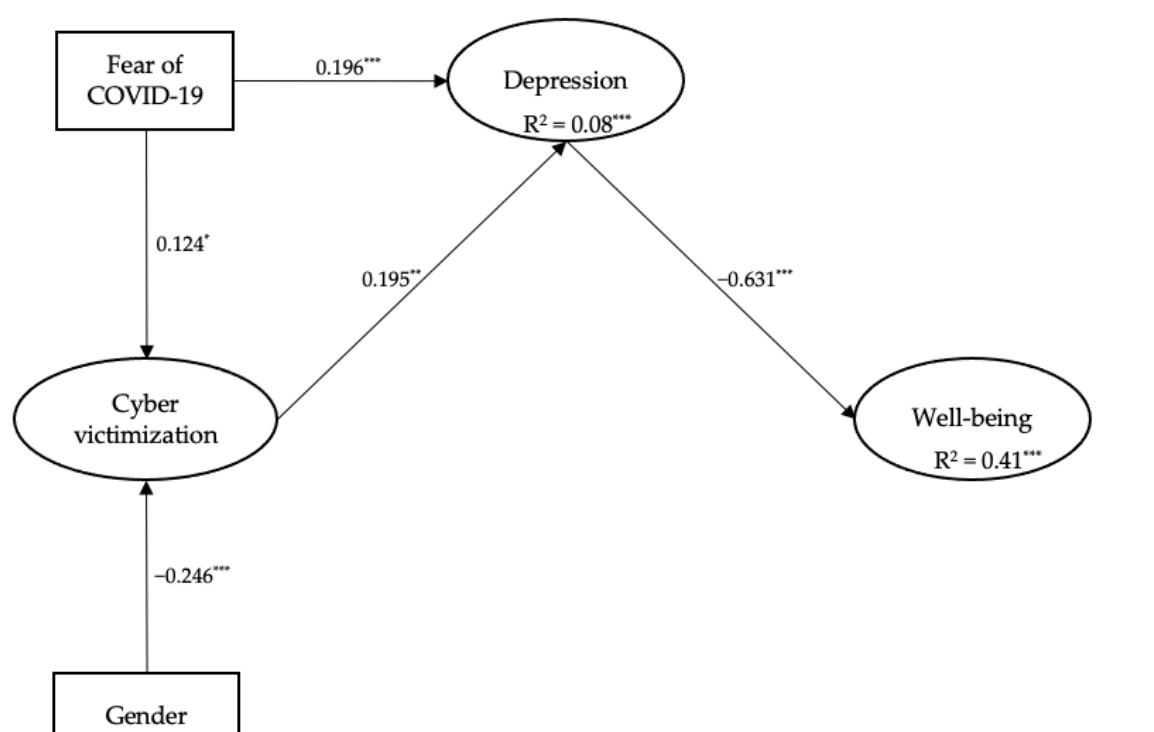
cant relationships are depicted in the figure. Latent factors are presented in the circle, and measured